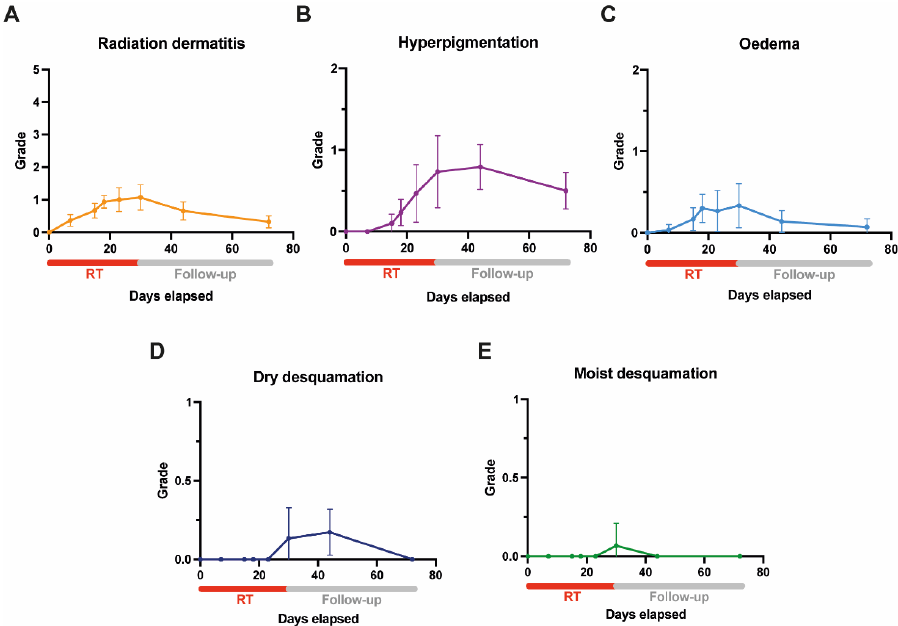
Figure 4. Evolution of mean acute toxicity for the entire cohort during (routine weekly on-treatment visits) and after (two- and six-weeks follow-up) adjuvant whole-breast irradiation in combination with NIPP: ( A ) radiation dermatitis, ( B ) hyperpigmentation, ( C ) oedema, and ( D ) dry and ( E ) moist desquamation. Grading according to the National Cancer Institute’s Common Terminology Criteria for Adverse Events (CTCAE) v5.0 [20]. Error bars indicate 95% confidence intervals. NIPP = non- invasive physical plasma; RT = radiation treatment.